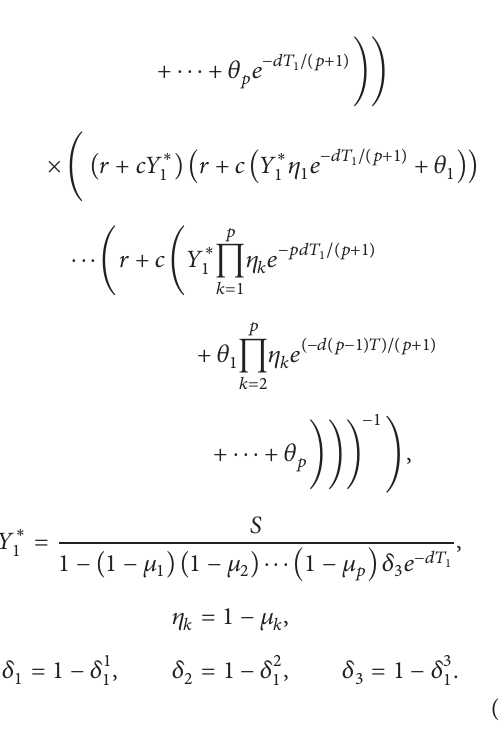
Figure 3: The impact of the number and dosage of application insecticides on pests and natural enemy with parameters of (a) 𝛿 1 = 0.9 , 𝛿 2 = = 0.85 , 𝜃 = 0 , 𝑇 = 6 , and 𝑞 = 1 , (b) 𝛿 0.85 , 𝛿 3 0.85 , 𝜃 = 0 , 𝑇 = 6 , and 𝑞 = 6 , and other parameters the same as Figure